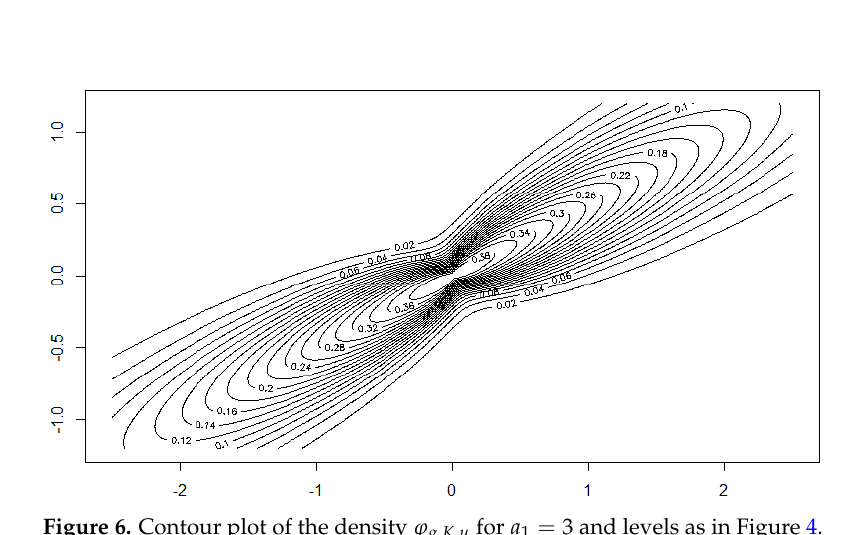
Figure 6. Contour plot of the density ϕ g , K , µ for a 1 = 3 and levels as in Figure